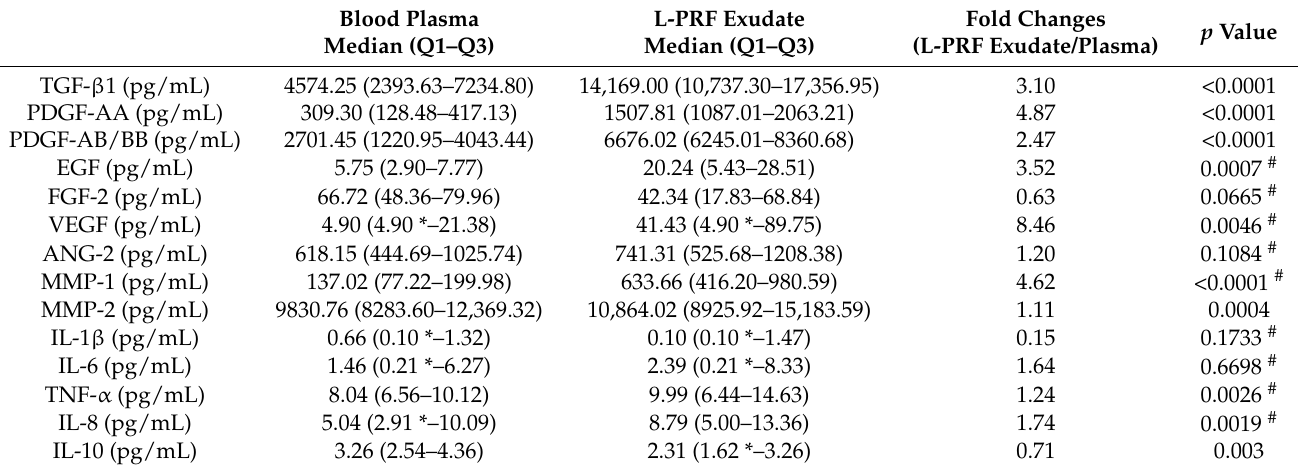
Table 2. GFs, cytokines, and MMPs concentrations in plasma and L-PRF exudate.